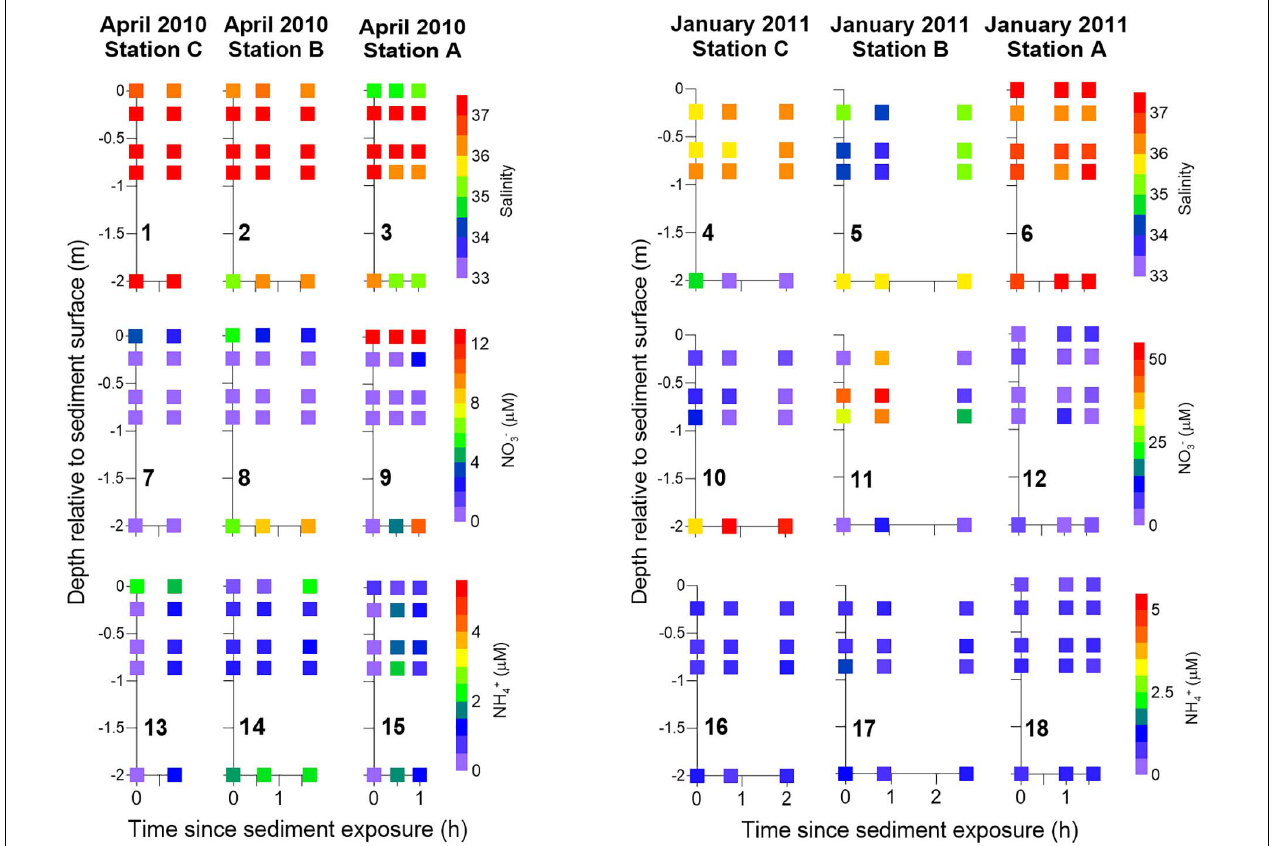
FIGURE 7 | Temporal solute distribution within the seepage face during the period of active seepage, i.e., during sediment exposure, organized by sampling station during April 2010 and January 2011. Porewater salinity (panels 1–6), NO 3 − (panels 7–12), and NH 4 + (panels 13–18) are shown. Samples were collected with piezometers and seepage meters. Seepage meter data corresponding to half an hour around the time of piezometer sampling were integrated at each sampling station and presented at the sediment surface. White squares represent lack of data. Note the different scale in the NO 3 − concentrations between April and